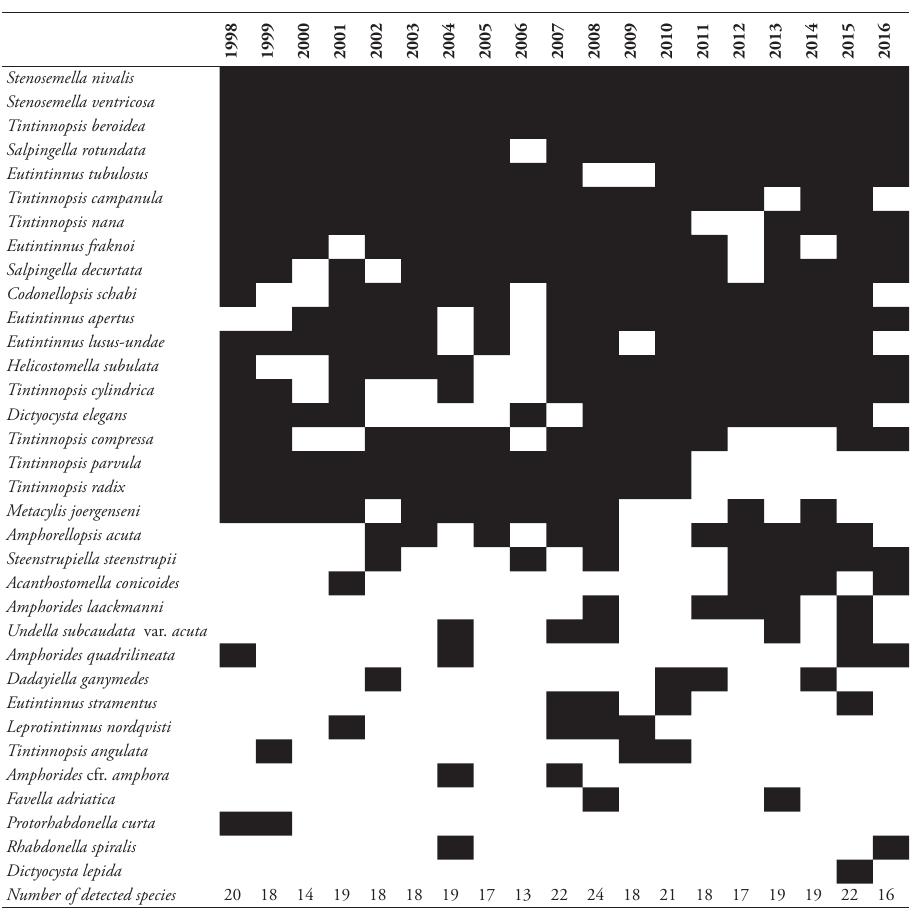
Table 3. Occurrence of each tintinnid species recorded in the studied period (1998-2016) in the Gulf of Trieste. Black squares indicate that the species was present at least once in the corresponding year. White squares indicate the absence of the species in those